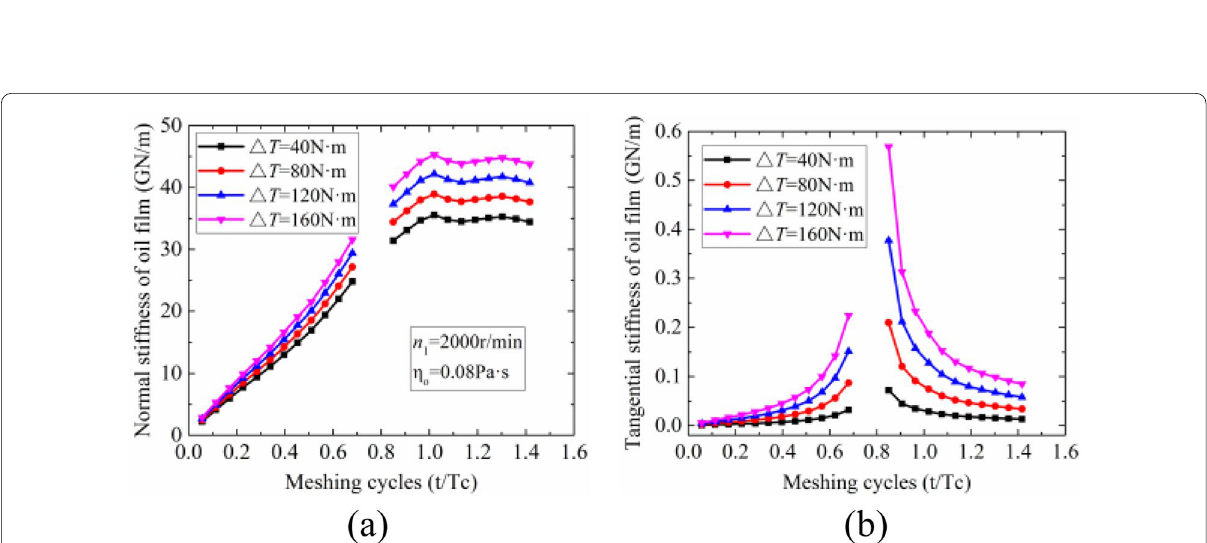
Figure 13 Influence of the input